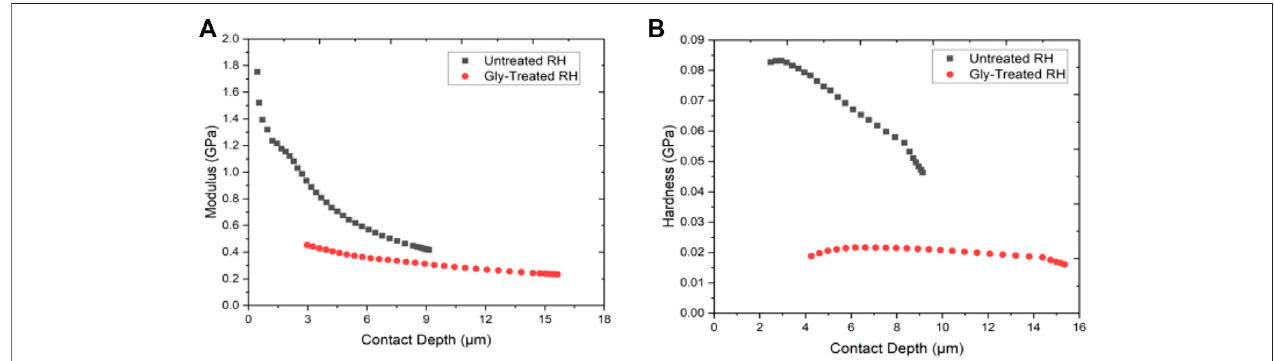
FIGURE 4 | Modulus and hardness as a function of contact depth: (A) modulus of untreated and Gly-treated RH; (B) hardness of untreated and Gly-treated RH.